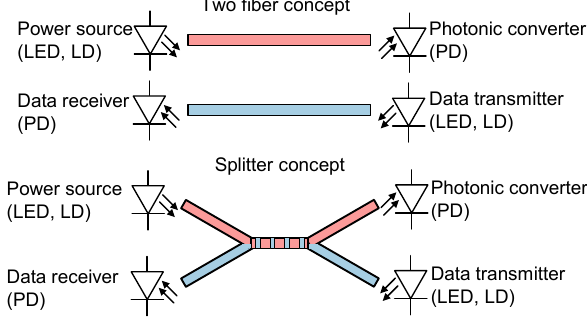
Figure 2. Current concepts for remotely powered sensor systems with four distinct photonic